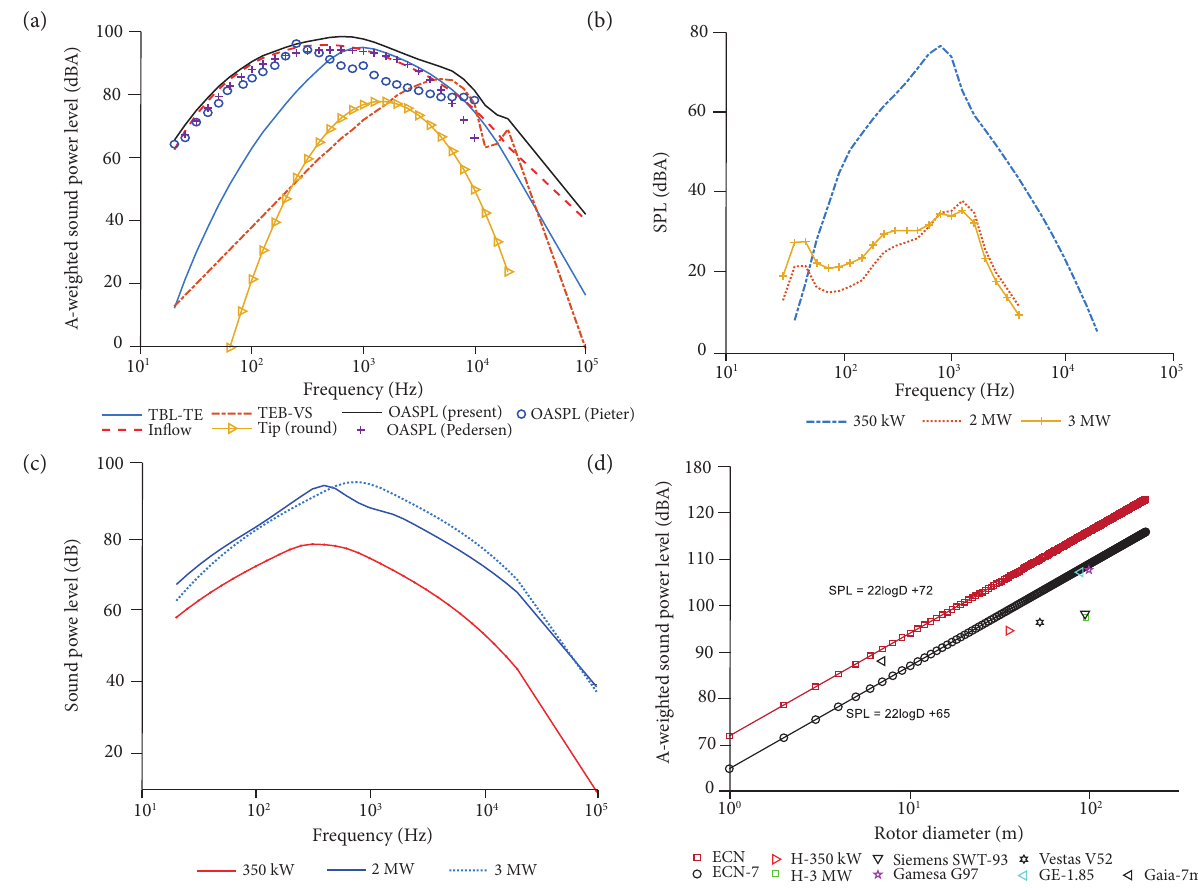
Figure 4. (a) Comparison of noise mechanisms and overall 1/3 rd octave A weighted sound power level, dBA, for 3 MW wind turbine, blade length 47 m with measured results for 2.3 MW turbine, blade length 47 m and 2.5 MW turbine of ~ 45 m blade length; (b) comparison of LBL-VS for 350 kW, 2 MW and 3 MW turbines at wind speed of 8 m/s; (c) single source (TBL-TE) sound power levels from three wind turbines – 350 kW, 2MW and 3MW – at wind speed of 8 m/s and for 0° observer position; and (d) comparison of theoretical prediction of sound power levels with numerical results from BPM model and measured values from manufacturer data sound power level (SPL) was done for TBL-TE mechanism for three different turbine sizes. It shows trailing edge noise is high